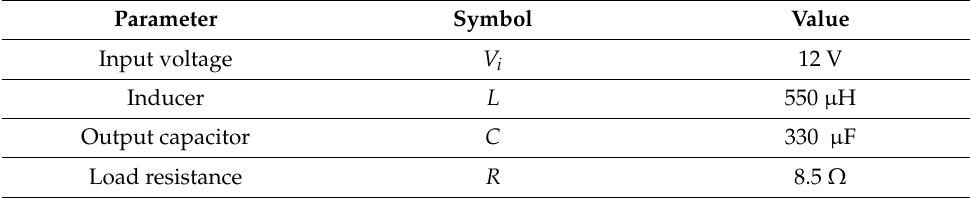
Assuming 𝑉 (cid:3045)(cid:3032)(cid:3033) = 5 V , converter reference current can be calculated using (4), which results in 𝐼 (cid:3045)(cid:3032)(cid:3033) = 0.83 A . Considering (28), the Jacobin matrix can be obtained using nomi- nal parameters.